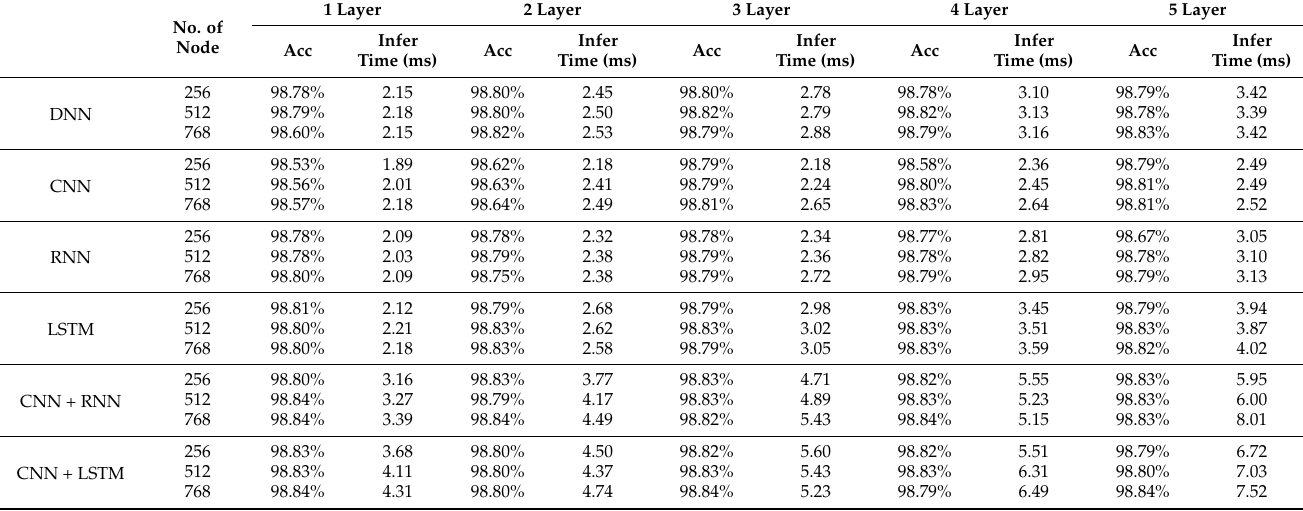
Table 20. The accuracy and inference time of DNN, CNN, RNN, LSTM, CNN + RNN and CNN + LSTM for multi-class